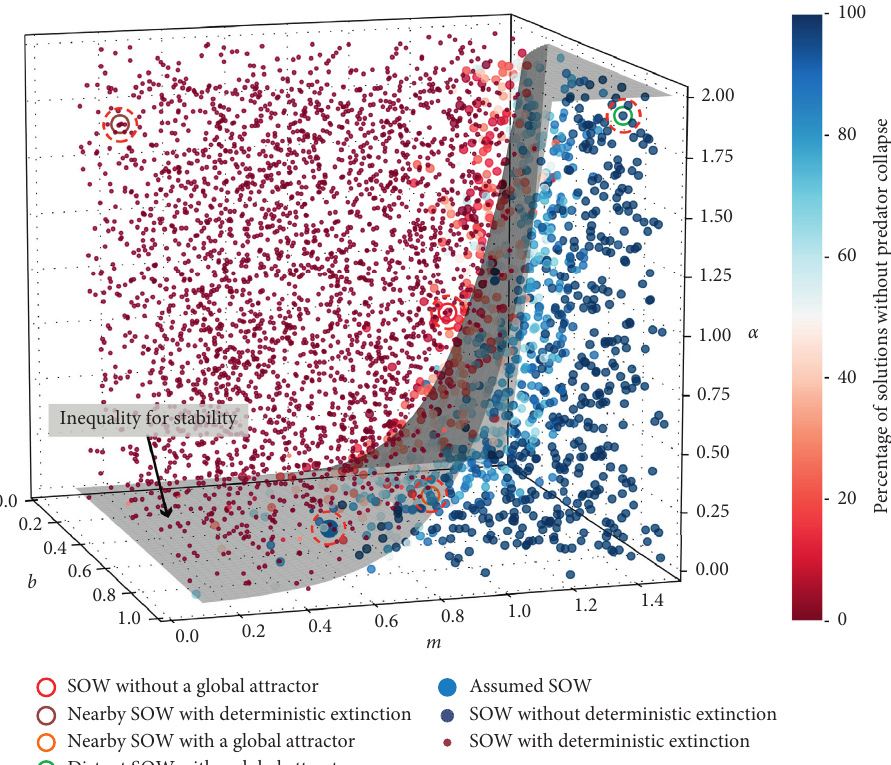
Figure 6: All the sampled SOWs, as they fall in the α , b , and m parametric space (all other parameters kept constant). The percentage of solutions that do not lead to any predator collapse when applied in each SOW is represented by the color at each point. Small points and large points indicate SOWs with and without deterministic extinction, respectively. The shaded surface indicates the inequality for stability (4), with all other parameters held constant at the default values and harvesting z assumed to be zero. The SOWs presented in Figure 4 are also contextualized in the parametric space.